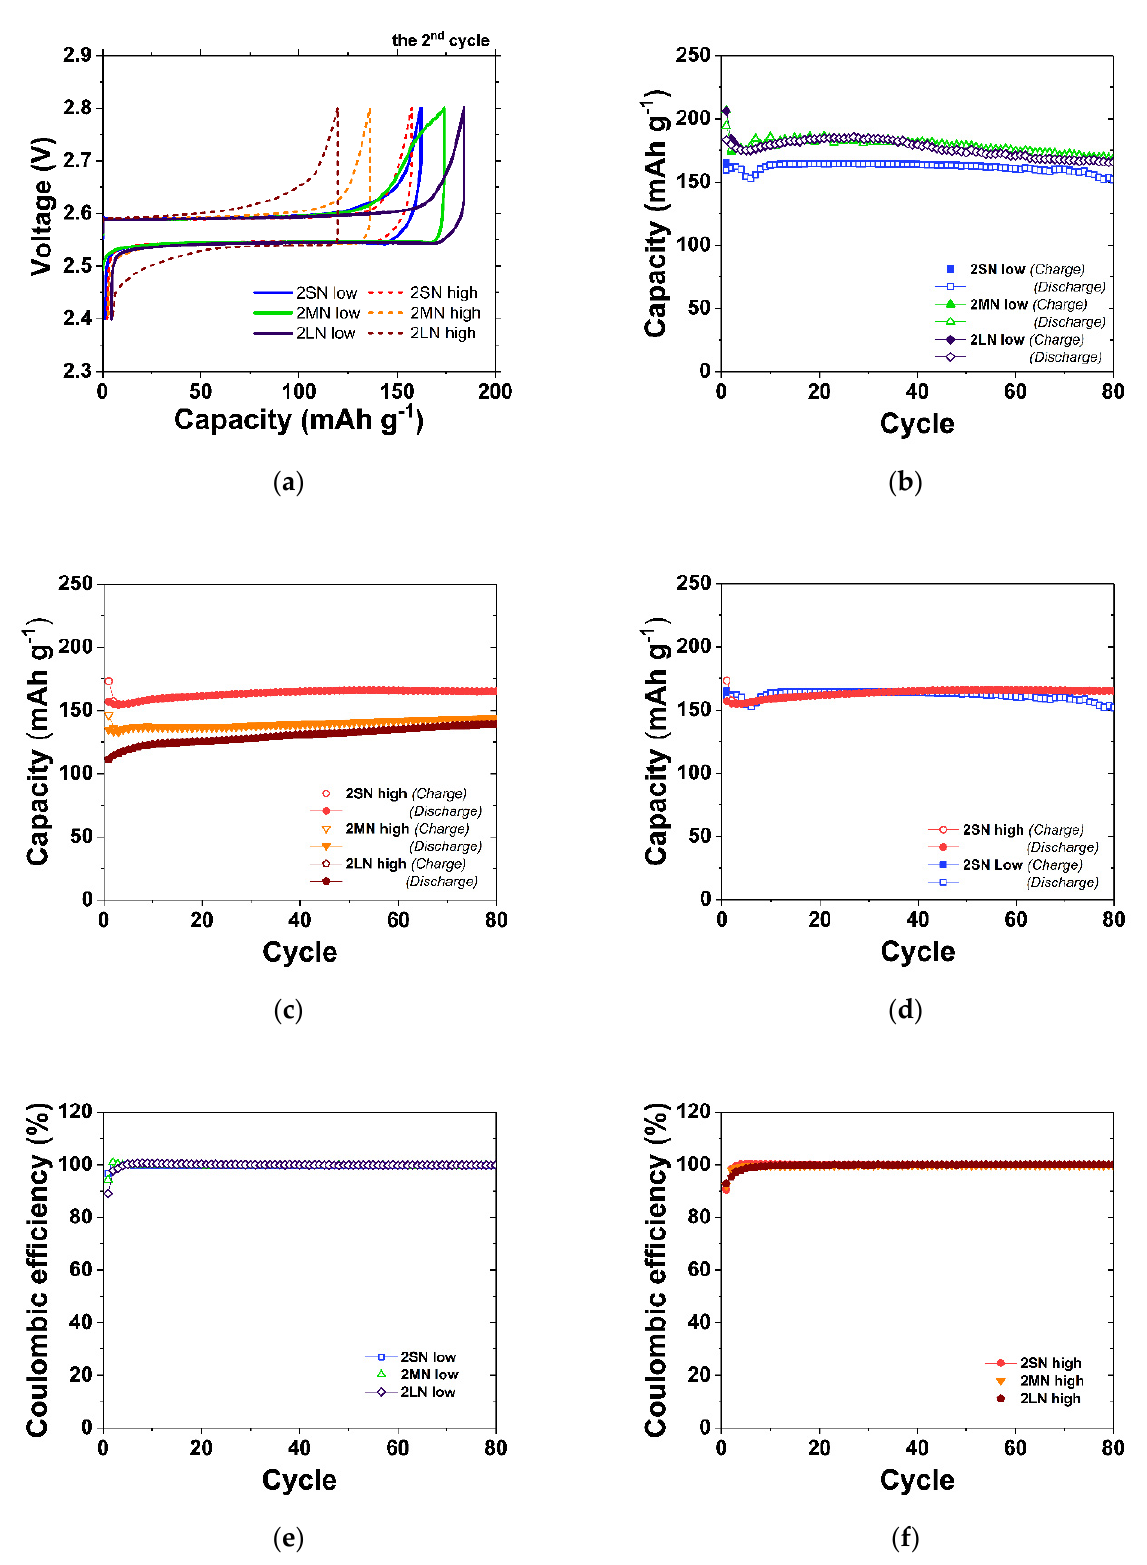
Figure 3. Electrochemical behavior of Na/NiCl 2 batteries. ( a ) Voltage profile of each cell at the second cycle; ( b ) cycling performance of low-density Ni cells to the 80th cycle; ( c ) cycling performance of high-density Ni cells to the 80th cycle; ( d ) comparison of cycling performance between 2SN-high and 2SN-low cells; ( e – f ) Coulombic efficiency.